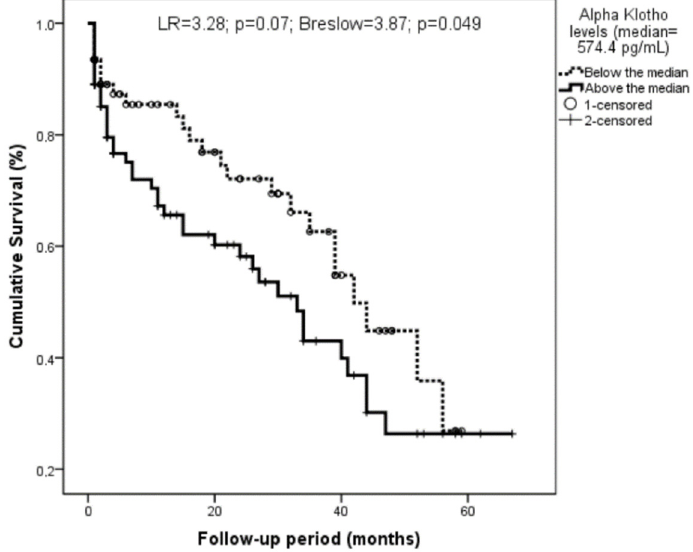
Figure 3. Relationship of Klotho with survival among the whole sample. Klotho levels were classified according to the median (574.4 pg/mL).